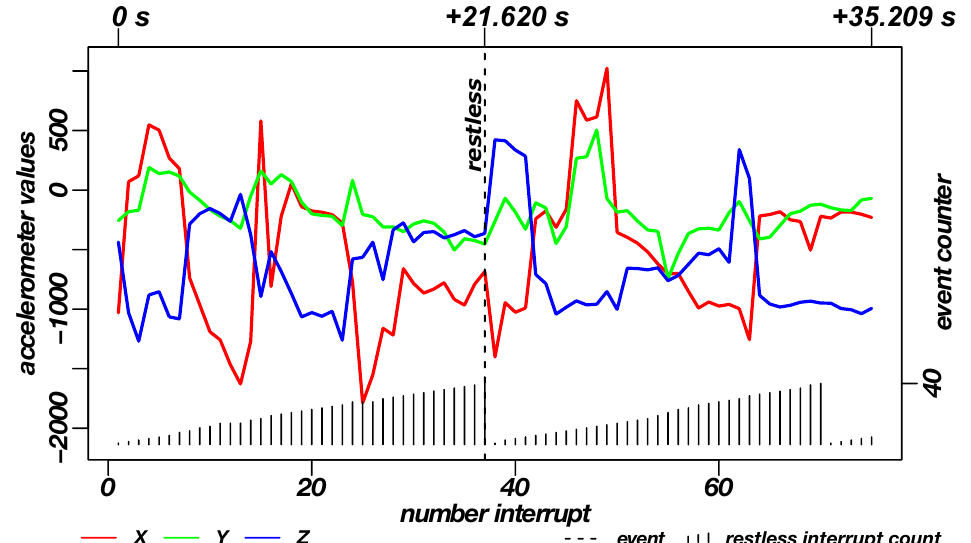
Figure 12. Diagram of the recorded data of the INBED wearables during a restlessness measurement on the subject. By means of the red-green-blue graphs, the recorded raw triaxial acceleration data of the sensor node can be seen for each interrupt of the wearable. Plotted in the lower area is the restlessness counter state, which counts up to the threshold of 40. The counts are weighted by the kind of movement. A dashed line shows the triggering of the restlessness alarm in the diagram. In the upper part the time interval of different milestones to the first interrupt is